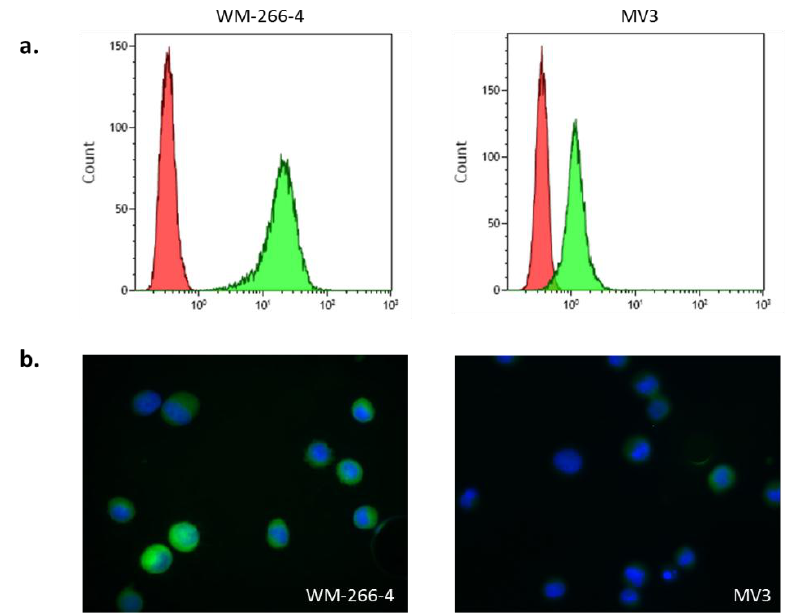
Figure 1. S100 protein expression in WM-266-4 and MV3 cells by ( a ) flow cytometry and ( b ) immunofluorescence analysis using the anti-S100 antibody 6G1 conjugated to AlexaFluor 488.